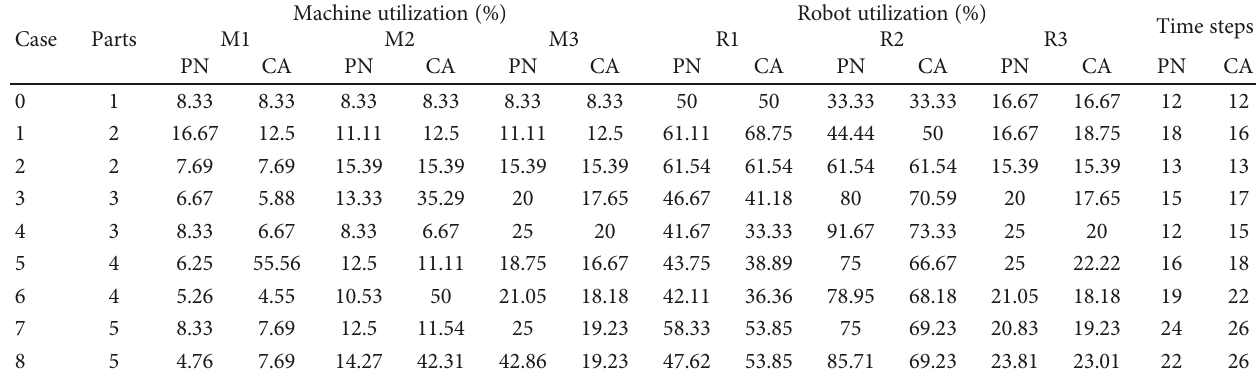
Table 3: Simulation results for the PN model and the cellular